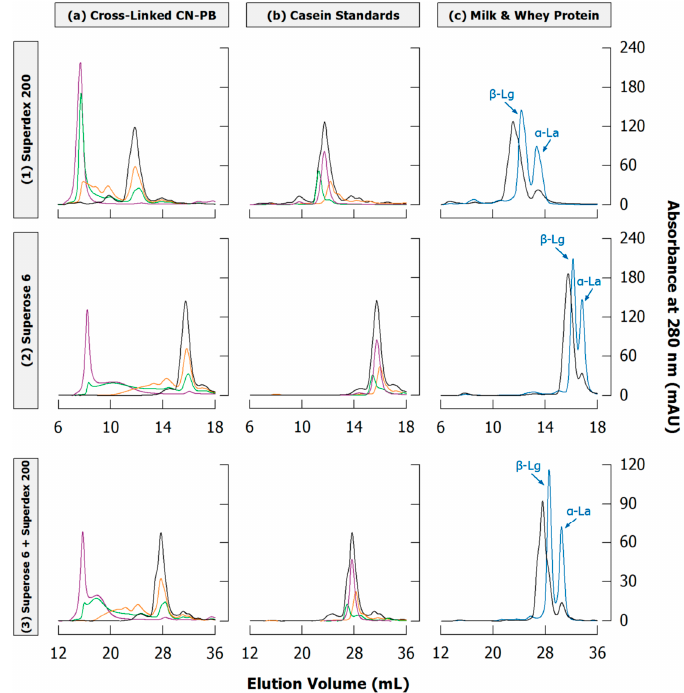
Figure 10. Sections of typical size exclusion chromatograms of casein samples obtained from ( 1 ) Superdex 200, ( 2 ) Superose 6, or ( 3 ) both columns in sequence under denaturing and reducing conditions (see Appendices A1 and A4 for experimental details). ( a ) Casein in phosphate buffer (CN-PB) cross-linked with transglutaminase for 0 (black), 1 (orange), 3 (green), or 24 h (violet); ( b ) Peak positions of α S -casein (violet), β -casein (green) and κ -casein (orange) in comparison to uncross-linked CN-PB (black); ( c ) Reconstituted skim milk (black) and whey protein isolate (blue) with the two peaks for α -lactalbumin ( α -La) and β -lactoglobulin ( β -Lg).